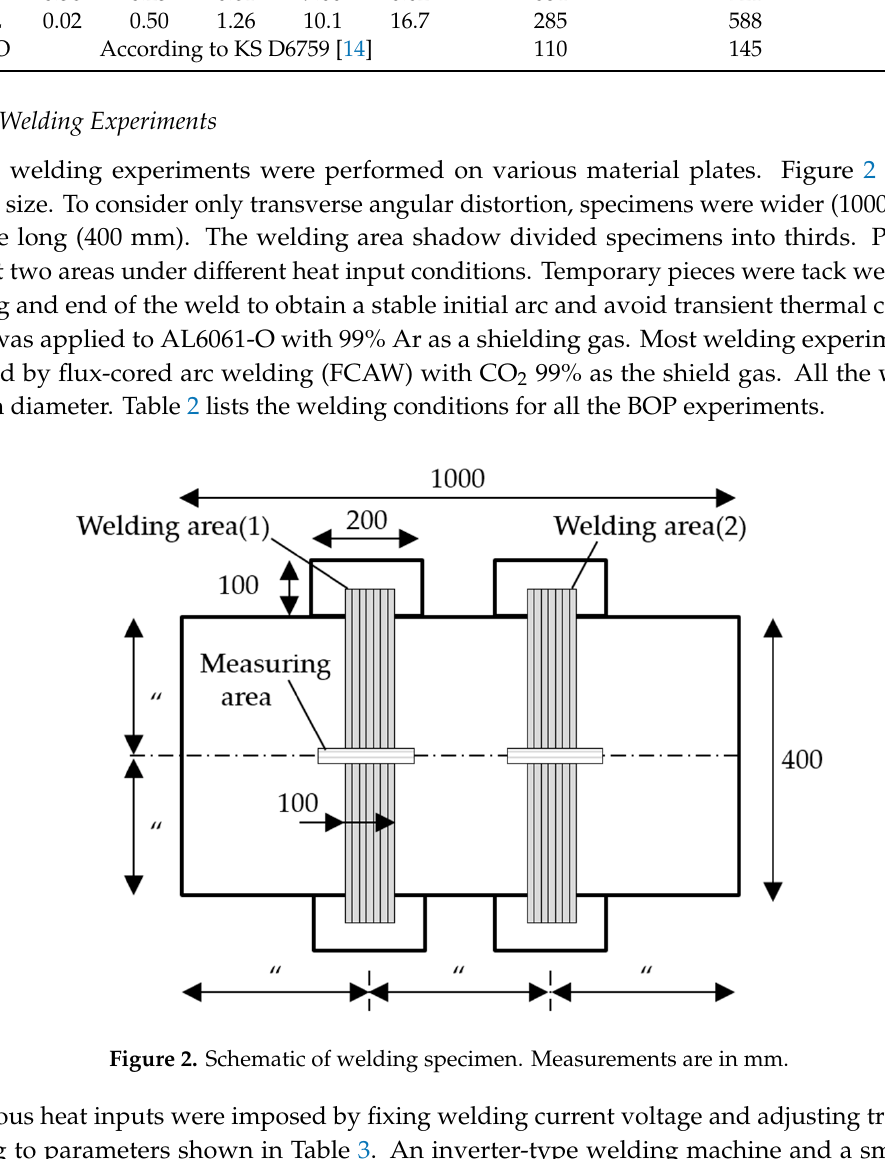
Table 1. Chemical compositions and mechanical properties of various materials.